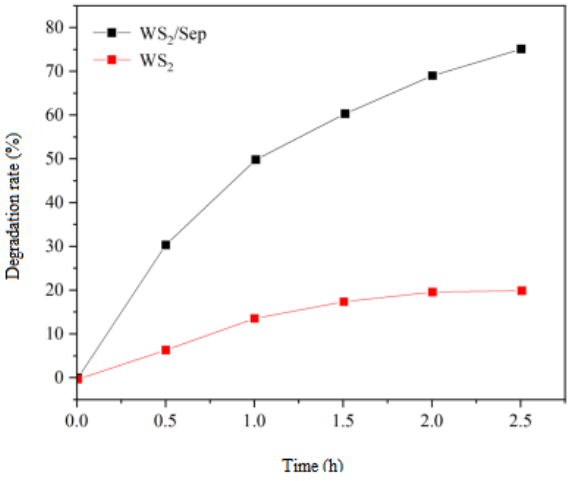
Figure 5. Photocatalytic activity of the WS 2 /Sep composite and pure WS 2 .